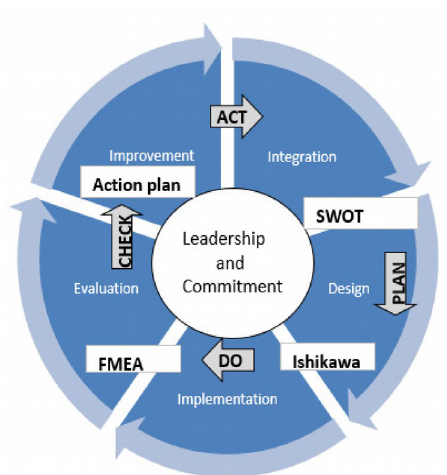
Figure 1. Risk management framework (Adapted from ISO 31000,